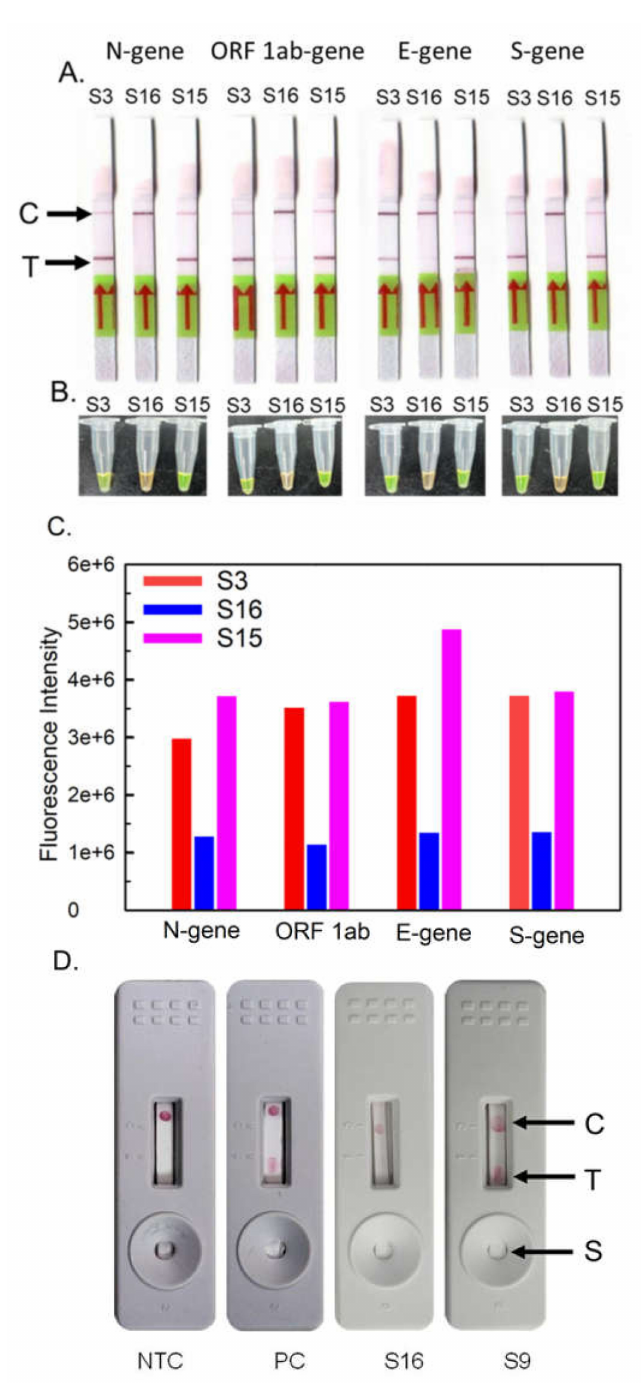
Figure 3. LFDs and visual detection for RT-LAMP amplified SARS-CoV-2 viral mRNA from pa- tient’s oropharyngeal and nasopharyngeal swab samples. ( A ) Lateral flow devices for three clinical samples S3 (Ct value: 12.978), S16 (Ct value: 38.539), and S15 (Ct value: 27.99). ( B ) Visual detection of RT-LAMP amplified clinical samples using SYBR Green I dye. ( C ) Fluorescence detection of RT-LAMP amplified clinical samples after 10-fold dilution using SYBR Green I dye. ( D ) Nucleic-acid-based lateral flow device (NALFD) for the RT-LAMP amplified samples; From left, cassette 1: Negative template control and cassette 2: customized N-gene (10 ng µ L − 1 ) as positive control; cassette 3: RT-LAMP amplified SARS-CoV-2 clinical mRNA targeting N-gene; Negative sample S16 (real-time PCR Ct value 38.539) and cassette 4: Positive sample S9 (real-time PCR Ct value